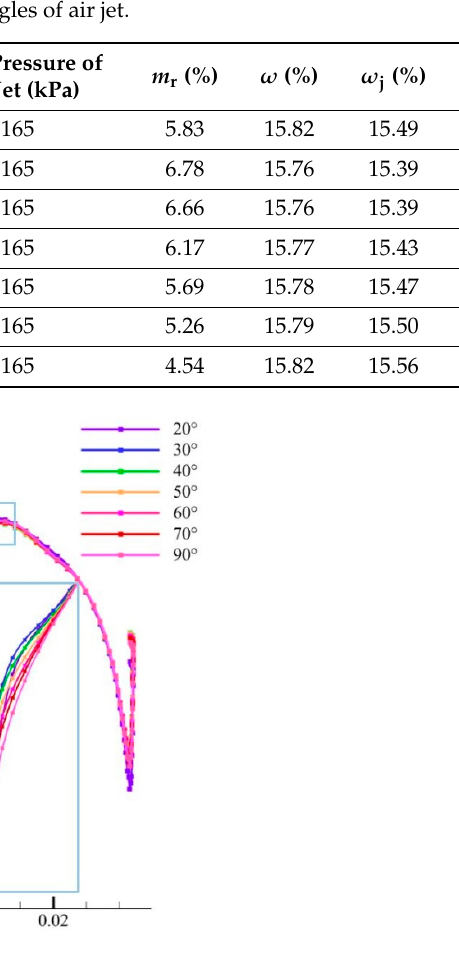
Figure 14. Static pressure distribution on blade surface with different angles of jet.